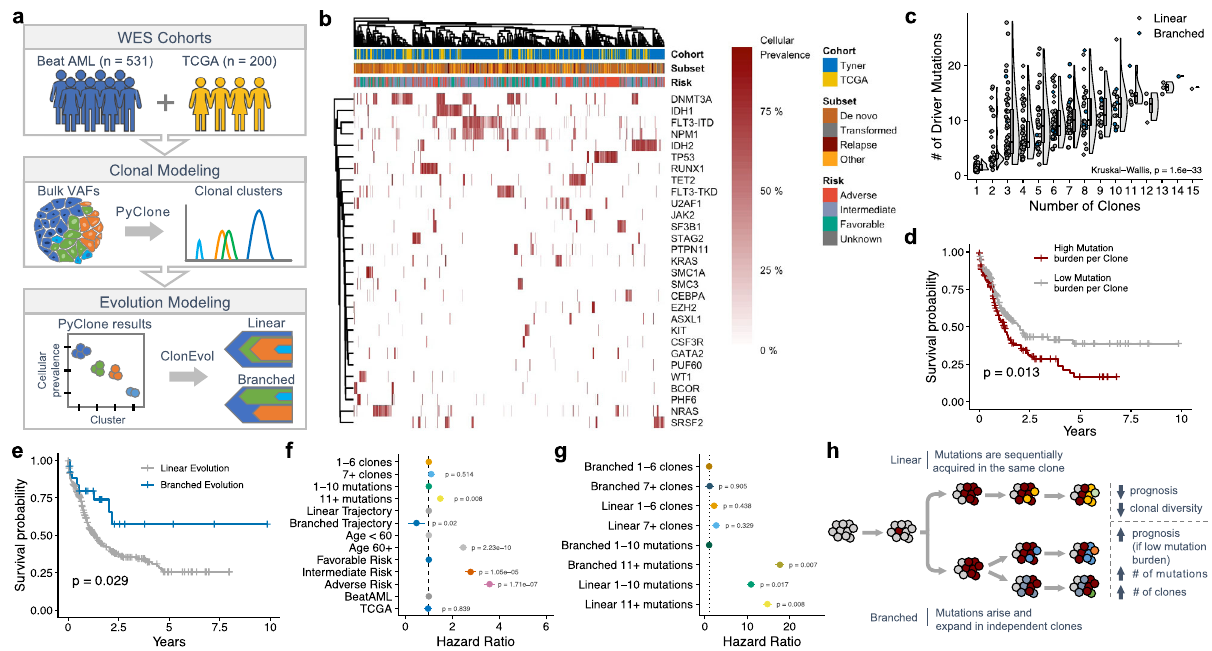
Fig. 5 Architecture of clonal evolution associates with survival outcomes. a Schematized work fl ow for modeling clonal architecture in a cohort of WES patients. Brie fl y, a deep-sequenced cohort was assembled and analyzed using PyClone to generate robust clonal populations and cellular prevalences. These cellular prevalence estimates were then leveraged to model the temporal acquisition of mutations and clonal architecture using ClonEvol. b Heatmap summarizing PyClone results of the per-patient cellular prevalence for the most common clonal genotypes. Each column is an individual patient sample grouped by hierarchical clustering based on similarity in clonal patterns. For patients with multiple mutations in the same gene, only the mutation with the largest cancer cell fraction (CCF) is shown. c Correlation between mutation burden and the number of unique clones derived from PyClone in the de novo cohort (Kruskal – Wallis p = 1.6e − 33; n = 409 patients). Points are colored by broad clonal evolution architecture as determined by ClonEvol (blue = branched evolution; gray = linear evolution). For each distribution, the boxplot represents the boundaries for the fi rst and third quartiles with a line at each median; whiskers delimit the highest data point below the third quartile + 1.5× the interquartile distance and the lowest data point above the fi rst quartile − 1.5× the interquartile distance. d Kaplan – Meier plot showing the association between higher median mutational burden per clone (red curve) and worse outcomes in de novo patients (two-sided log-rank test). e Kaplan – Meier plot showing the association of improved outcomes in patients exhibiting branched evolutionary architecture (blue curve = branched evolution; gray curve = linear evolution; two-sided log-rank test). f Forrest plot depicting univariate Cox proportional-hazards ratios for various aspects of the clonal architecture analyses. g Forrest plot depicting univariate Cox proportional- hazards ratios for clonal and mutational burden risk strati fi cation based on linear or branched architecture. h Schematic depicting the different genetic and clinical features associated with evolutionary architecture. Source data are provided as a Source Data fi